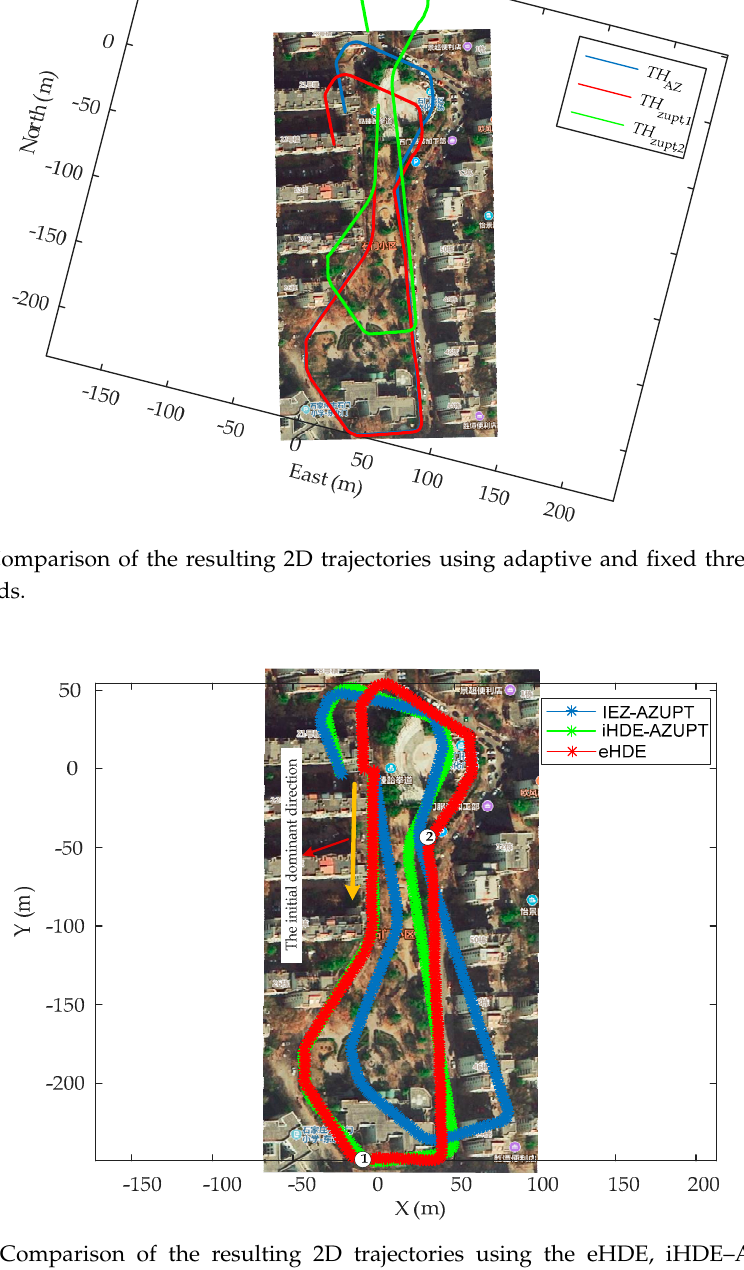
Figure 17. Figure 17. Comparison of the resulting 2D trajectories using the eHDE, iHDE–AZUPT, and IEZ– AZUPT algorithms.